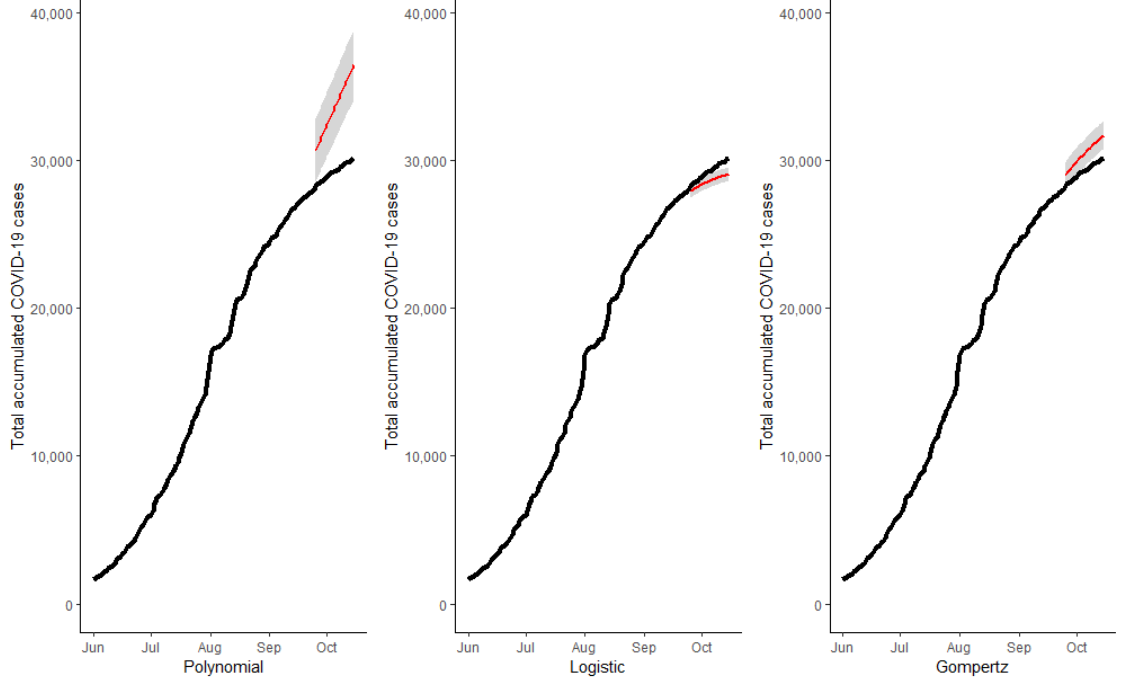
Figure 5. Forecast for total accumulated cases at 21 days for the state of Tamaulipas.